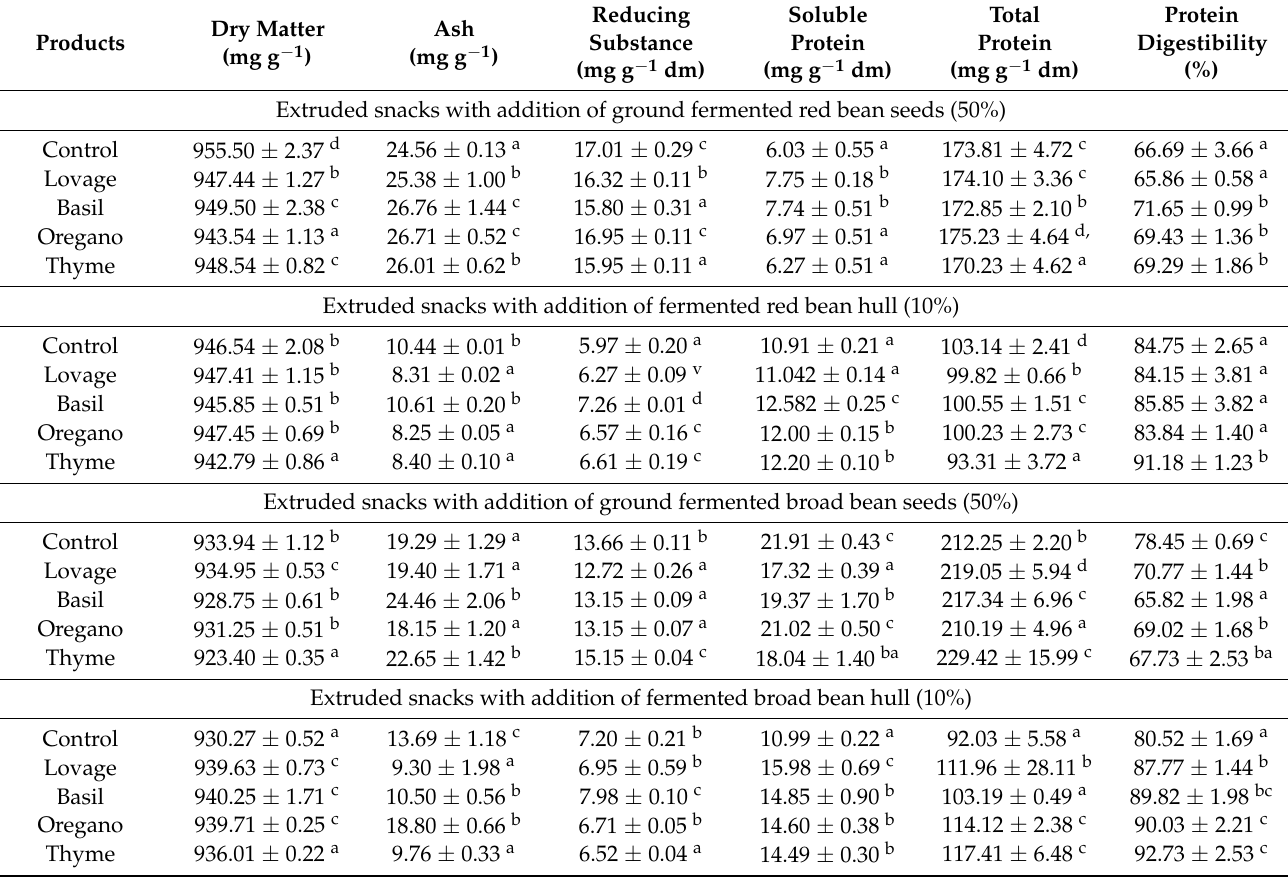
Table 1. Chemical composition and protein digestibility of extruded snacks with the addition of fermented red or broad bean seeds/hulls and with herbs/species (0.5%), and the controls (without herbs/spices